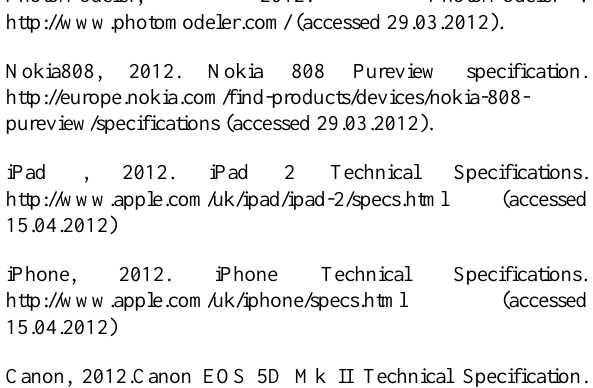
Figure 14. 3D difference map of the front (top) and the back (bottom) facade between the Canon and the iPhone 3D model The comparison indicates the presence of relatively small differences with the maximum being only 3 cm. This is mainly caused by small differences in the 3D coordinates of corner points that form the 3D planes. Some systematic patterns can be seen.